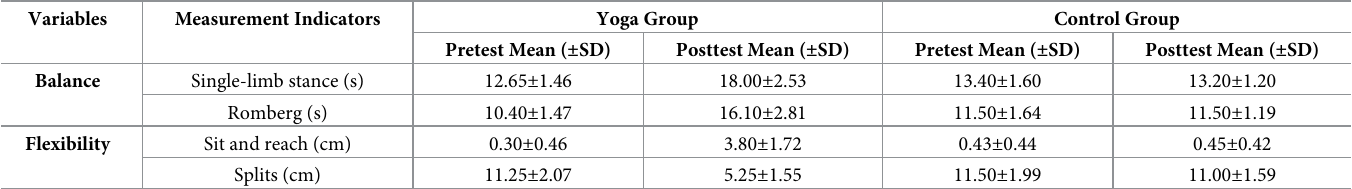
Table 4. Comparison of balance and flexibility between the yoga and control groups.